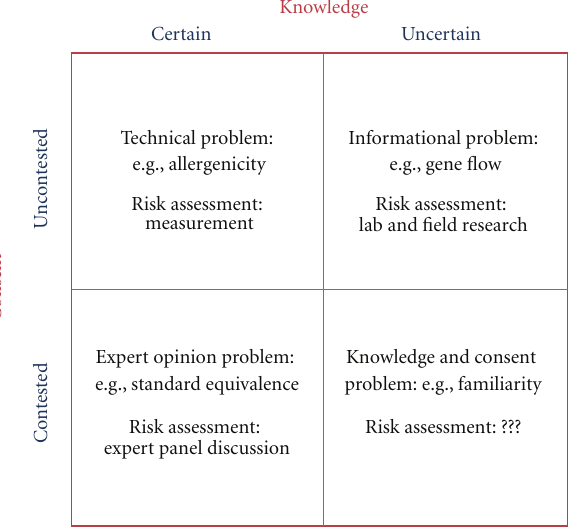
Figure 1: Modified from Douglas and Wildavsky’s “Four Problems of Risk” to include examples potentially relevant to GMO risk assessments